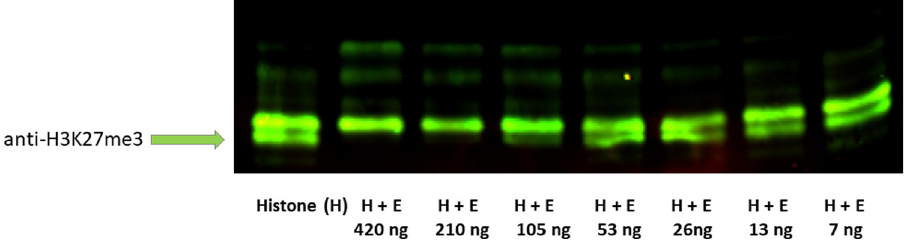
Fig 5. Recombinant B. malayi UTX-1 (E) serial diluted incubated with total bovine histone (H) constant. Recombinant B. malayi UTX-1 activity assay. Purified histones (600 ng) were used for each reaction with varying amounts of enzyme (420–7 ng). An anti-H3K27me3 was used to detect the methylation status after an overnight incubation. BmUTX-1 demethylates